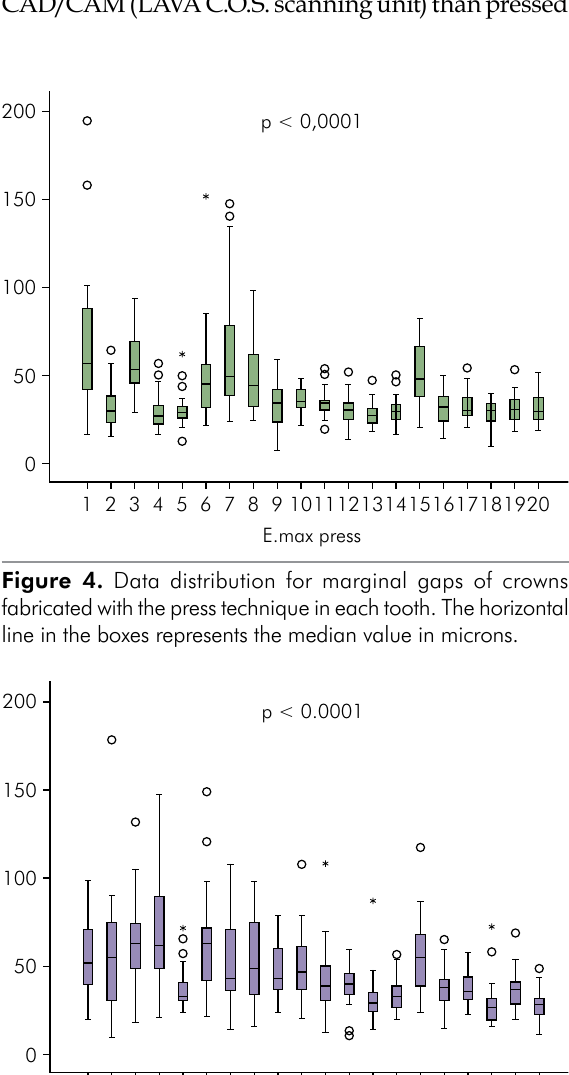
Table 1. Minimum, maximum, and mean marginal gaps of e.max press and e.max CAD crowns. CAD Press Median